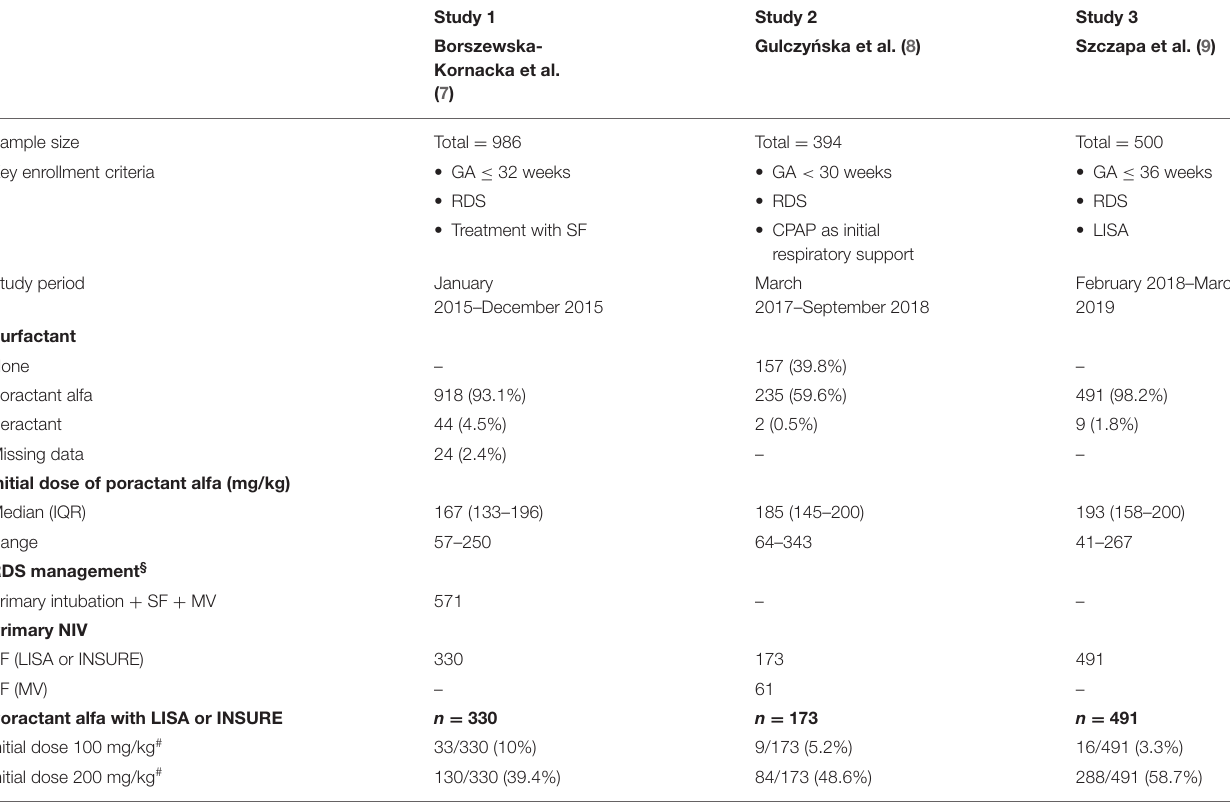
TABLE 1 | Summary of three neonatal RDS cohort studies combined in the